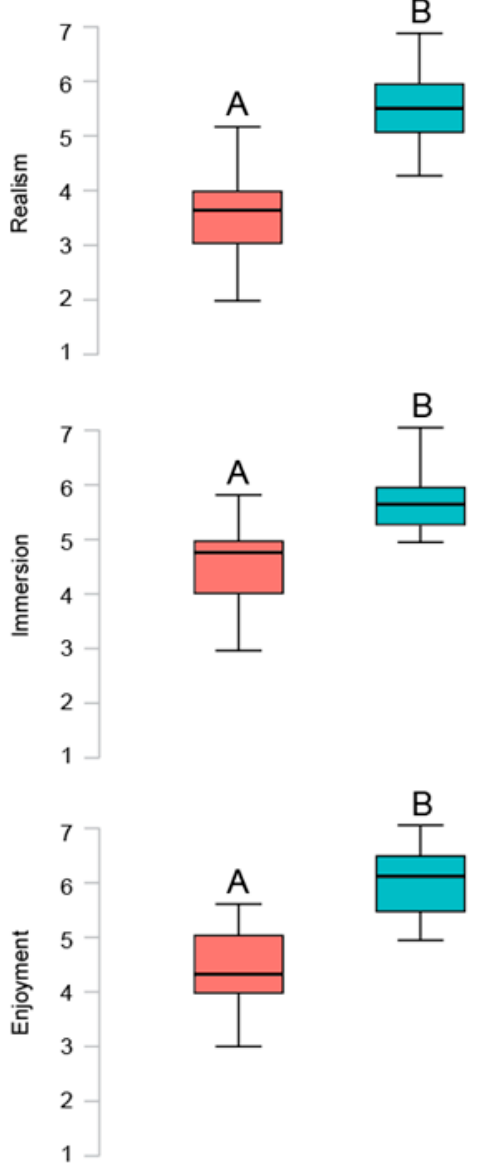
Figure 8. Average Likert-scale scores for realism, immersion, and enjoyment (A: when only the controller was used; B: when the HapTug device and the controller were used together).